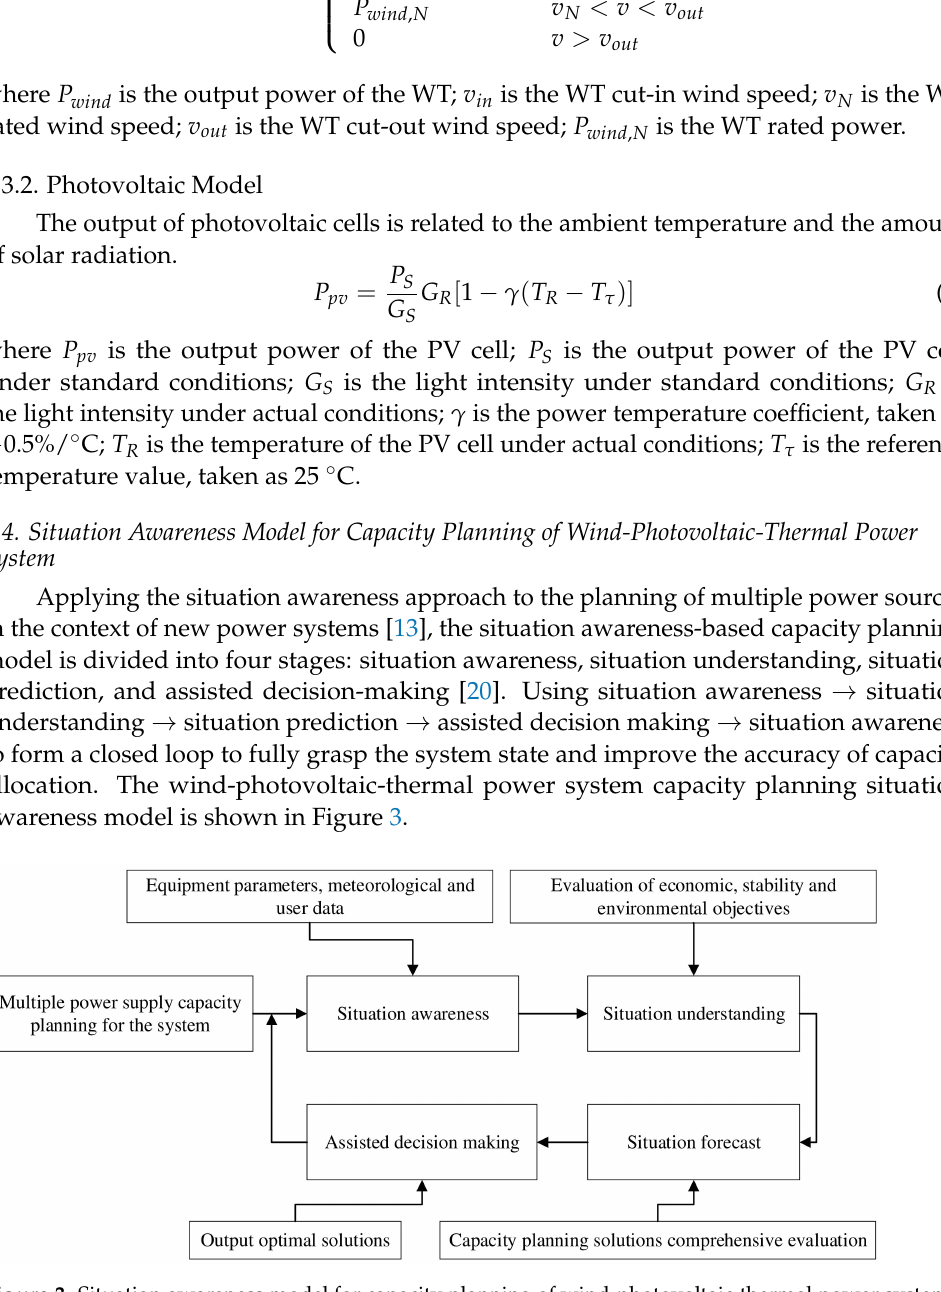
Figure 3. Situation awareness model for capacity planning of wind-photovoltaic-thermal power systems.